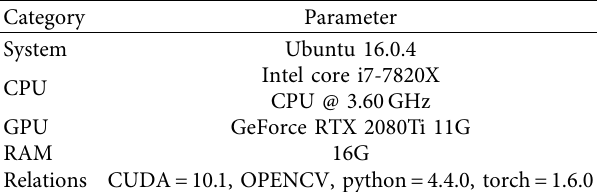
Table 2: Experimental